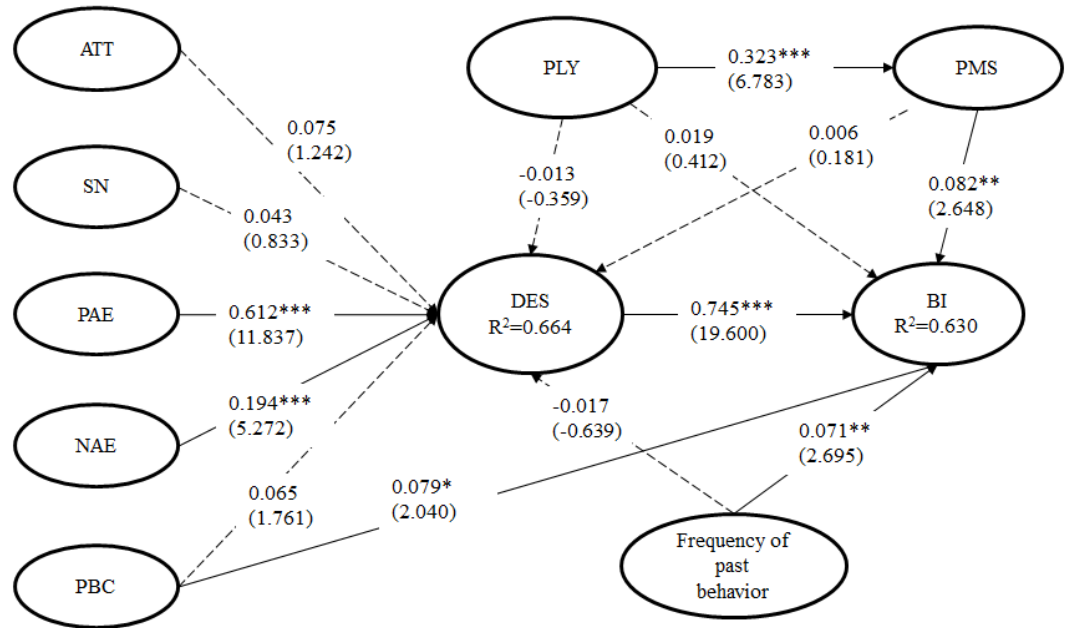
< 0.05; ** p < 0.01; *** p < 0.001. Notes 2: ATT = Figure 1. Structural model results. Figure 1. Structural model results. Notes 1: * p